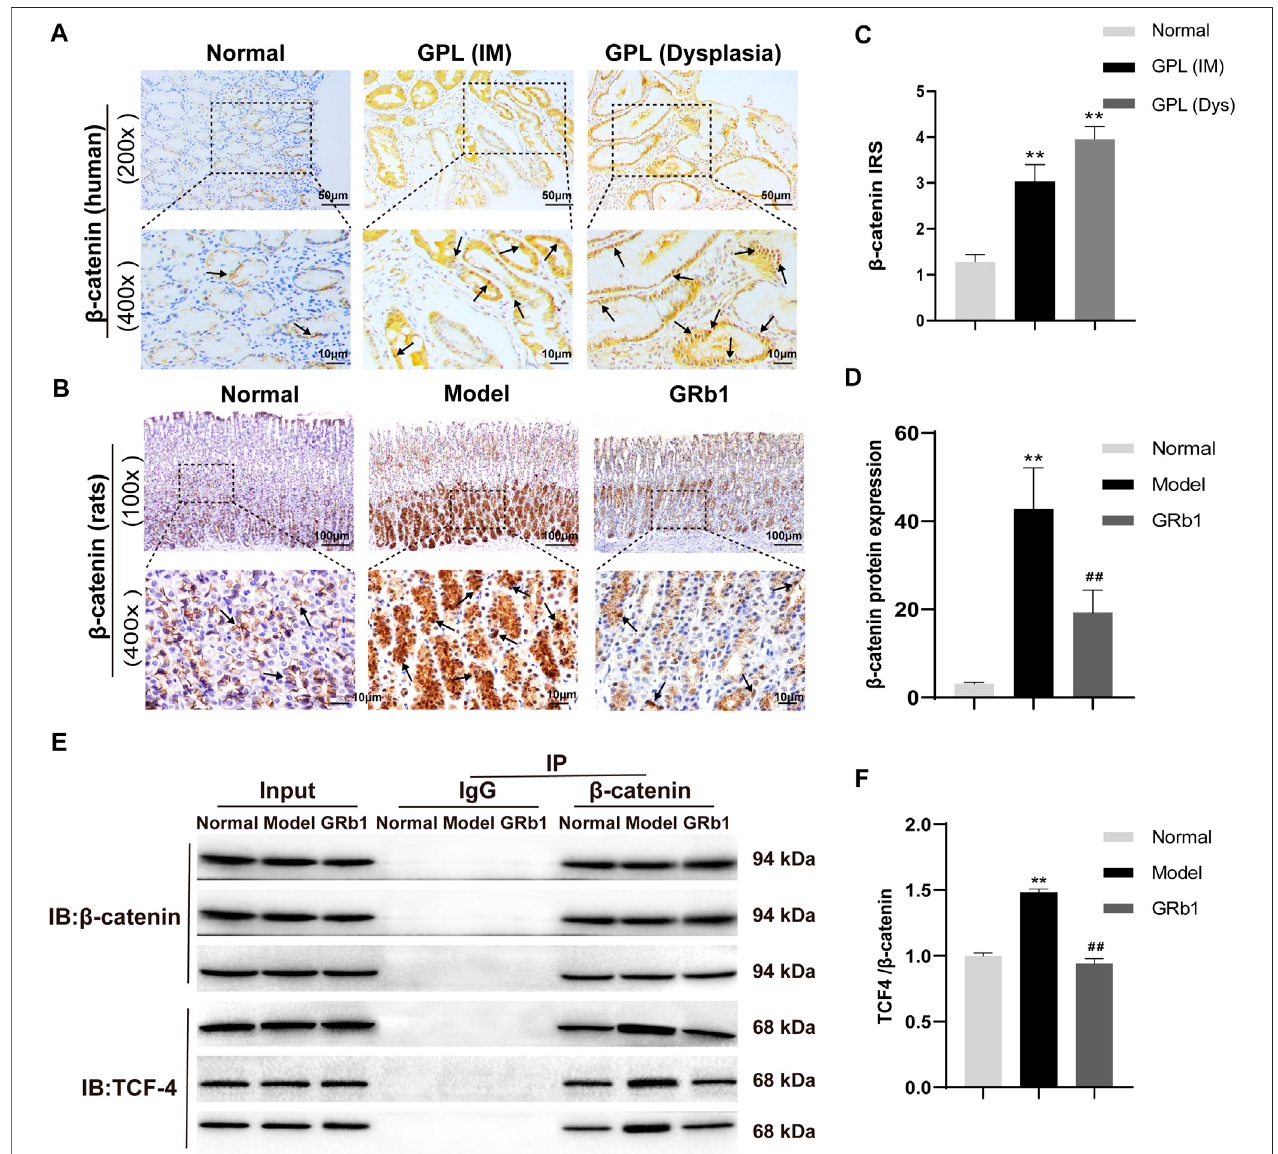
FIGURE4| Expressionpatternsof β -catenininbothhumanandanimalGPLspecimens,andtheeffectsofGRb1on β -Catenin/TCF4interactioninGPLmodelrats. RepresentativeIHC imagesdemonstratingtheexpression localizationof β -catenin inepithelialepitheliumfrom (A) humanspecimens(magni fi cation × 200, × 400)and (B) animalsamples (magni fi cation × 100, × 400). (C) Semi-quantitativeanalysisof β -catenin protein expression in human specimens ( n (cid:1) 179). (D) Semi-quantitativeanalysis of β -catenin protein expression levels in animal samples ( n (cid:1) 10). (E) Representative bands illustrate the β -Catenin/TCF4 interaction. Immune precipitation for β -catenin was performed with an IgG antibody as a control, and then TCF4 was detected using western blotting. (F) Quanti fi cation of the intensities of western blotting bands ( n (cid:1) 6). * p < 0.05 and ** p < 0.01 vs. Normal group. # p < 0.05 and ## p < 0.01 vs. Model group. Data are presented as mean ± SEM. Abbreviations: GRb1, ginsenoside Rb1; GPL, gastric precancerous lesions; TCF4, transcription factor 7-like two; IHC, immunohistochemistry; SEM, standard error of mean.